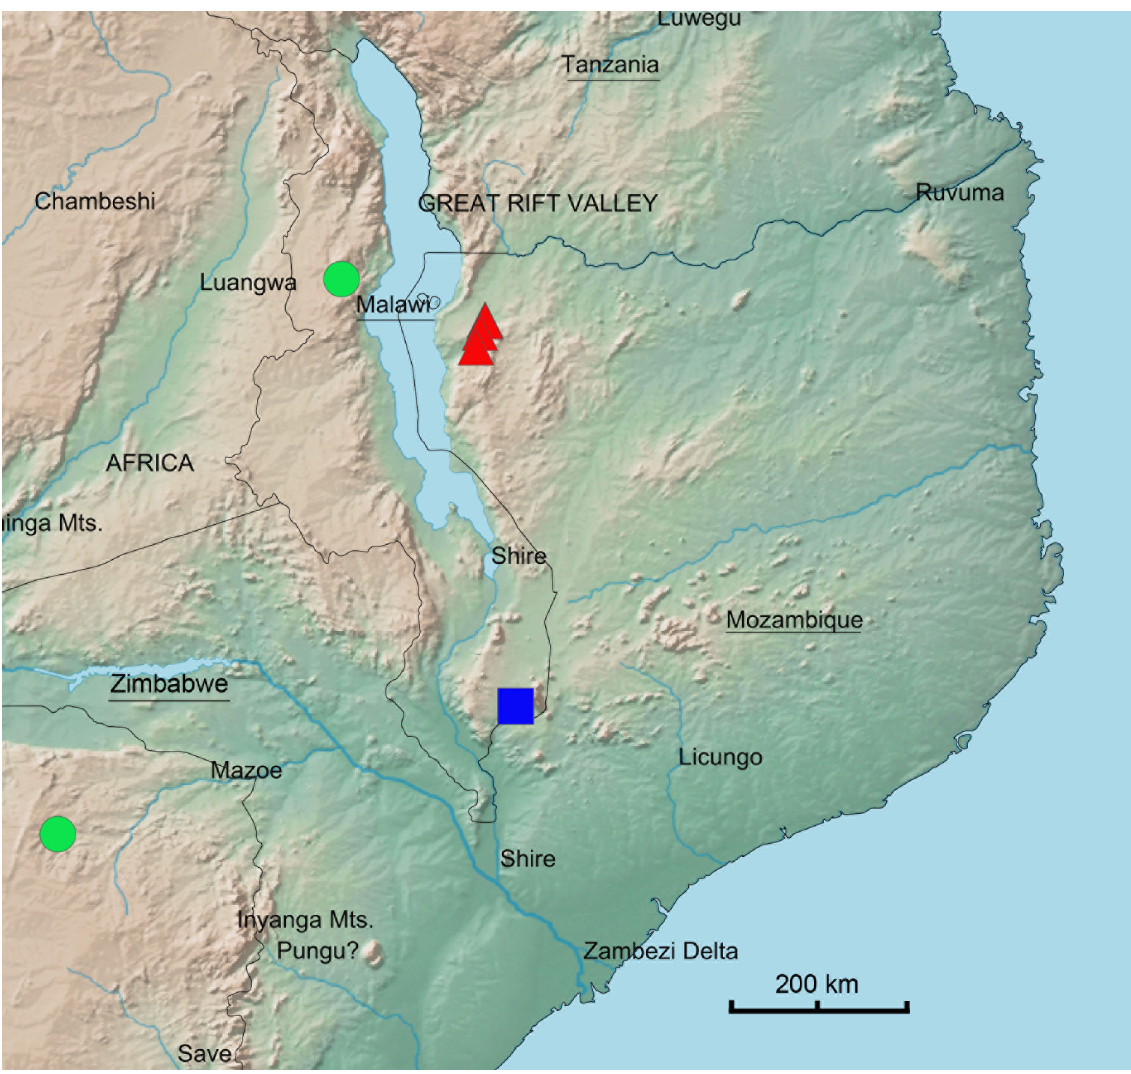
Fig. 8. Distribution. Xevioso cepfi sp. nov. (▲), Xevioso jocquei Griswold, 1990 (■), Xevioso megcummingae sp. nov.